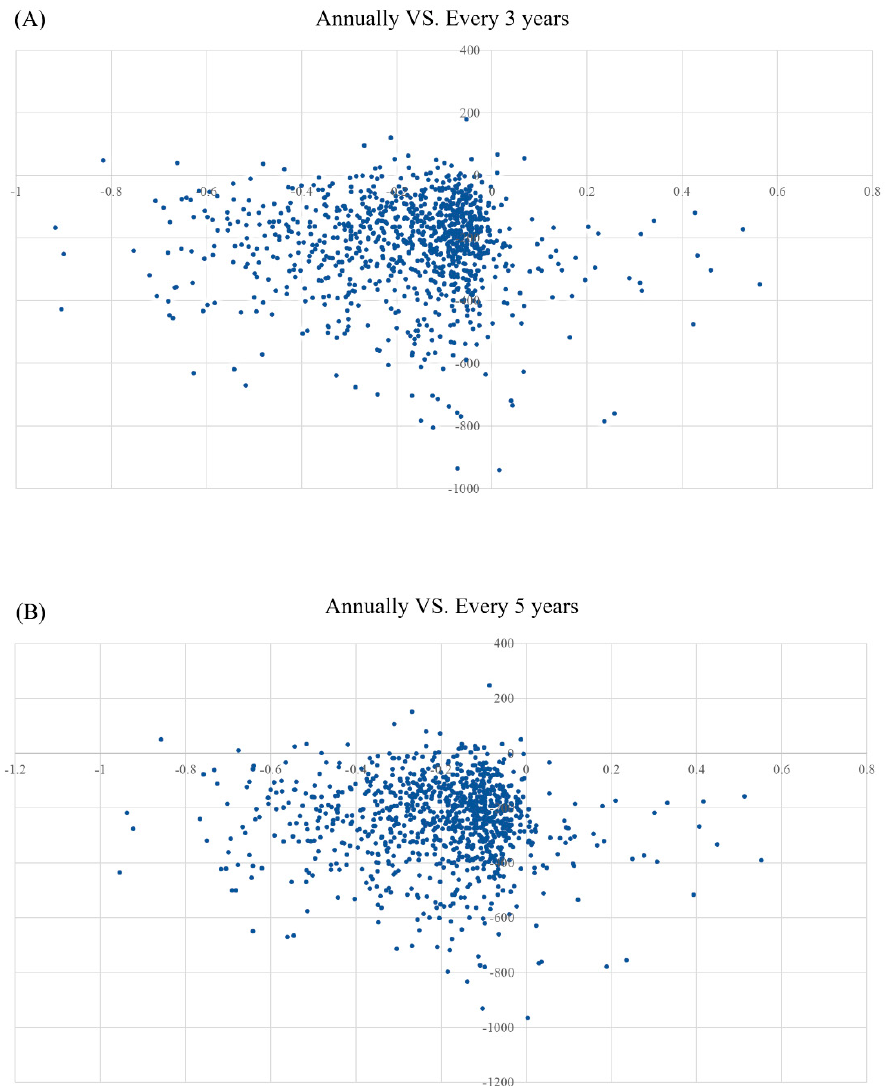
Figure 4. ( A ) CE plane showing the incremental costs and incremental QALYs of 1000 simulations for Annually group vs. Every 3 years group. ( B ) CE plane showing the incremental costs and incremental QALYs of 1000 simulations for Annually group vs. Every 3 years group.